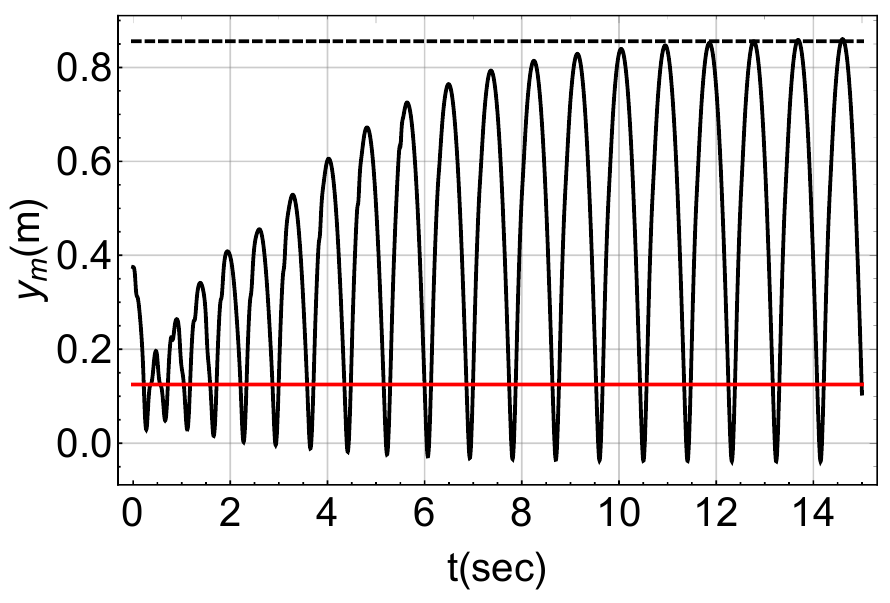
Figure 11. Basketball Super Jump Response, λ k = 0.105 and ω d =